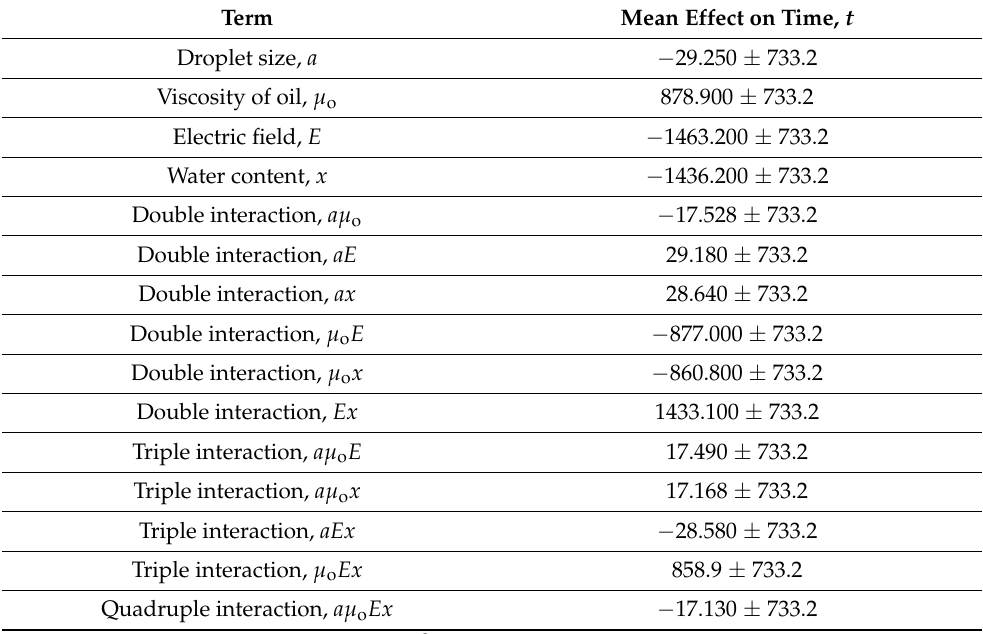
Table 5. Mean effect of the variables and their